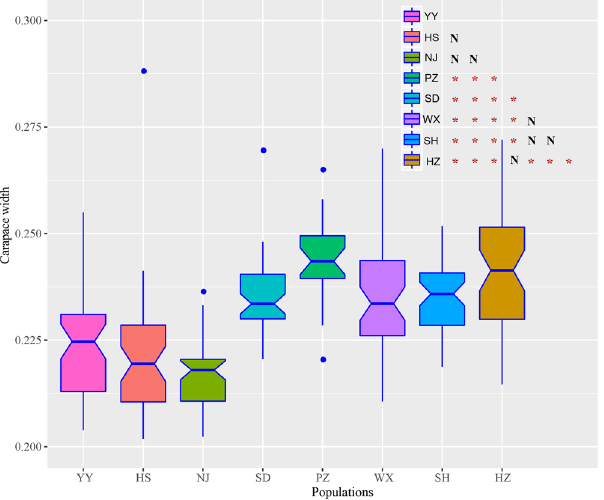
Figure 5. The morphological divergence of carapace width in the eight populations. The symbols below the diagonal in the top right corner represent the significance level in ANOVA. N indicates P > 0.05; asterisk indicates P <